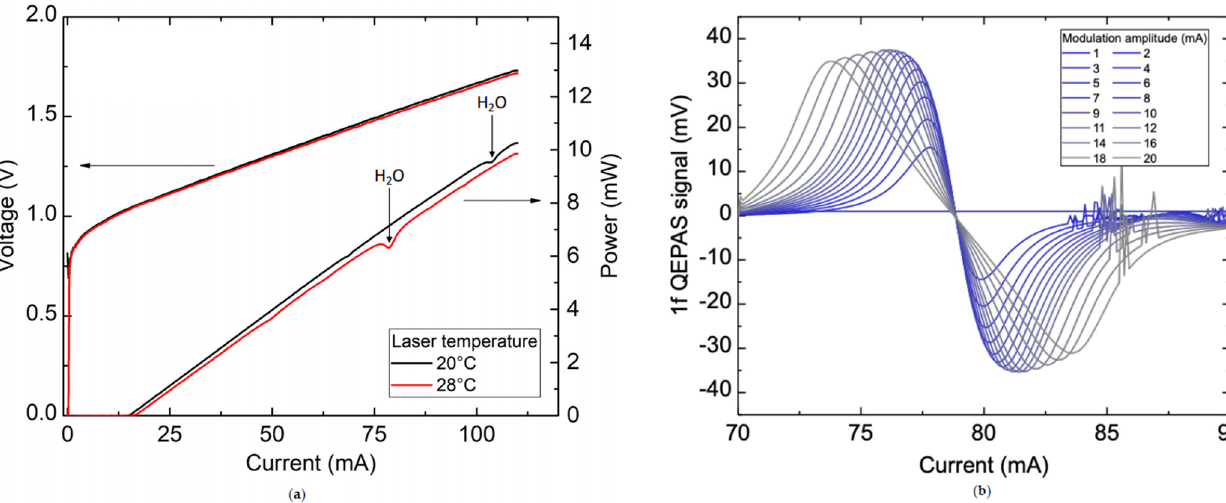
Figure 2. Characteristics of the EBLANA 1392 nm DFB laser. ( a ) LIV curves and ( b ) 1f-QEPAS response in an off-beam configuration with a single microresonator. The spikes at higher currents were due to insignificant experimental artefacts. The QEPAS response was obtained for a laser temperature of 28 °C and ambient humidity of 50% RH.